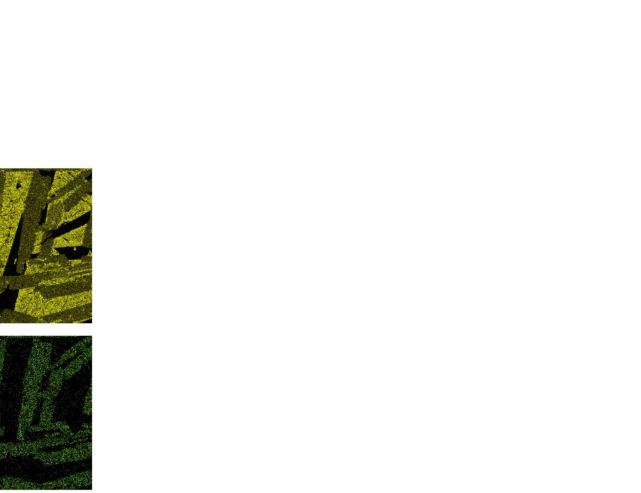
Figure 3. Photograph of coarse Al–Si alloy and elemental distributions of refined coarse Al–Si alloy. ( a ) coarse Al–Si alloy; ( b ) SEM of coarse Al–Si alloy; ( c ) Distribution of aluminum; ( d ) Distribution of silicon; ( e ) Distribution of